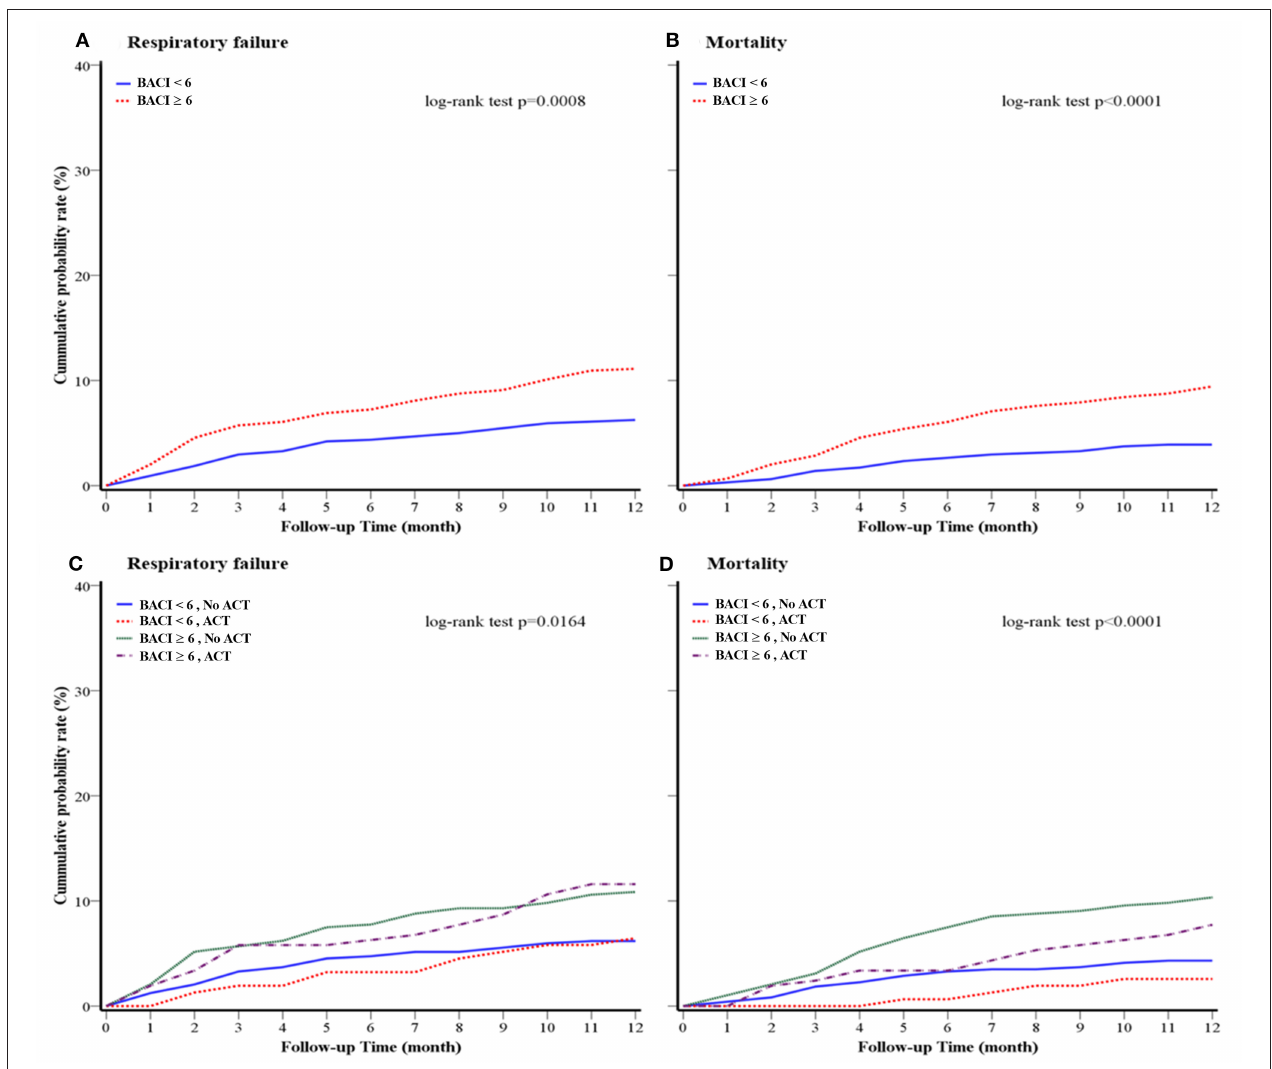
FIGURE 2 | Kaplan–Meier survival curves for (A) 1-year respiratory failure and (B) 1-year overall mortality of the cohort (BACI groups); (C) 1-year respiratory failure and (D) 1-year mortality of the cohort (BACI and ACT groups) after a 1-year follow-up. An indicative value of p was shown. ACT, airway clearance therapy; BACI, bronchiectasis etiology comorbidity